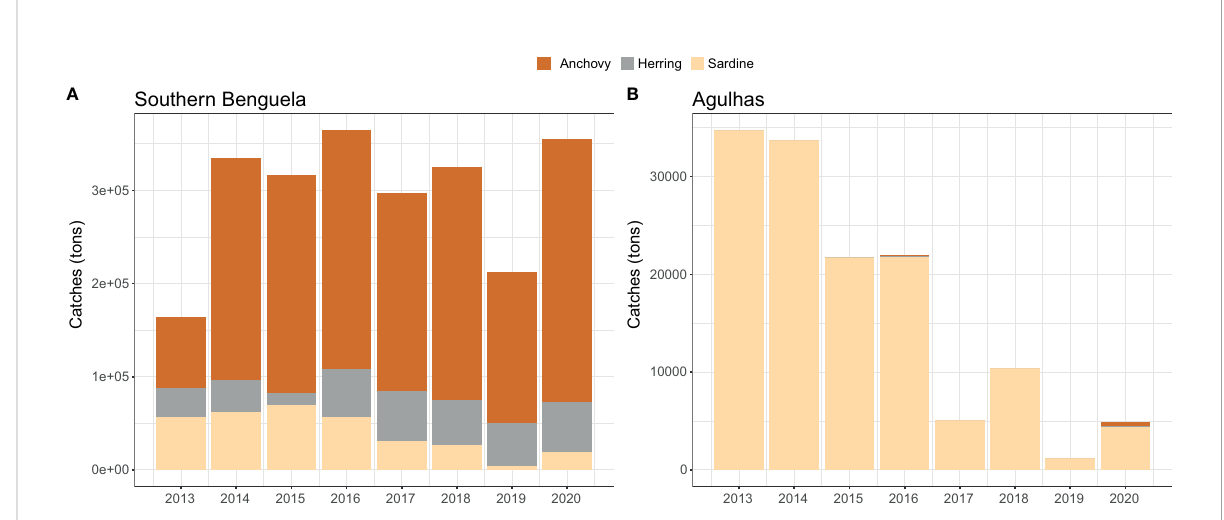
FIGURE 4 Yearly catches (tons) of three small pelagic fi sh species in (A) the Southern Benguela (west coast); and (B) the Agulhas (south coast) regions at the southernmost tip of